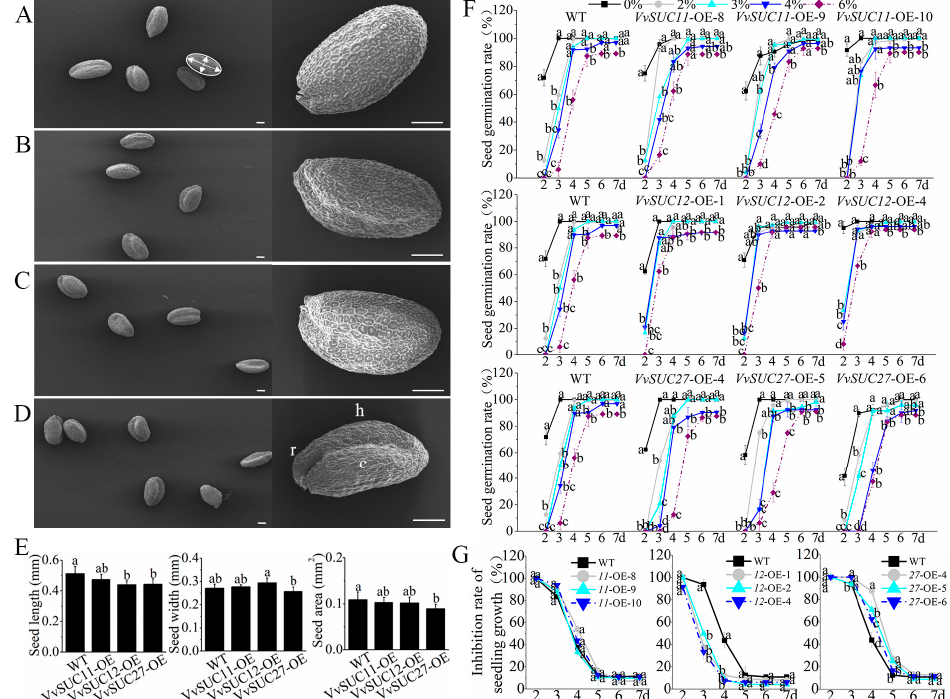
Figure 1. Morphological phenotypes of seeds and the effects of sucrose concentration on the seed germination of Vitis vinifera sucrose transporter ( VvSUC )-overexpressing (OE) Arabidopsis. ( A ) to ( D ) morphological phenotypes were observed by scanning electron microscopy in the ( A ) wild type